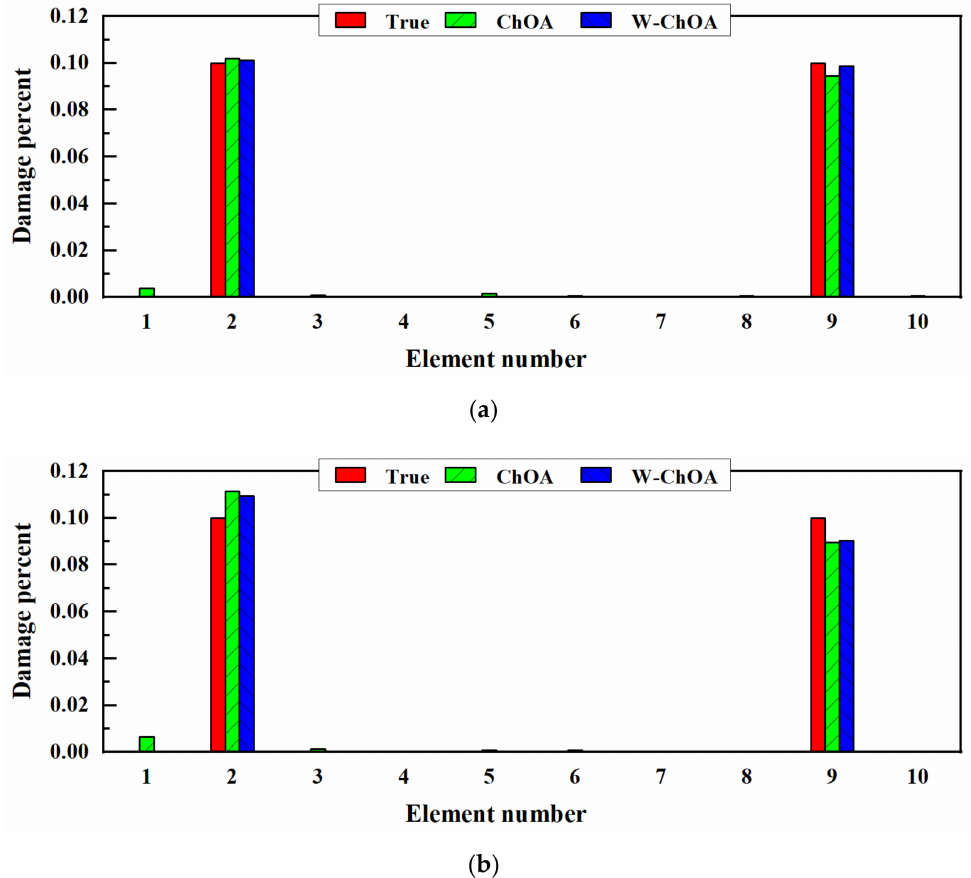
Figure 12. Symmetric damages detection results of the simply supported beam by two chimp-based optimization algorithms. ( a ) 5% noise level. ( b ) 10% noise